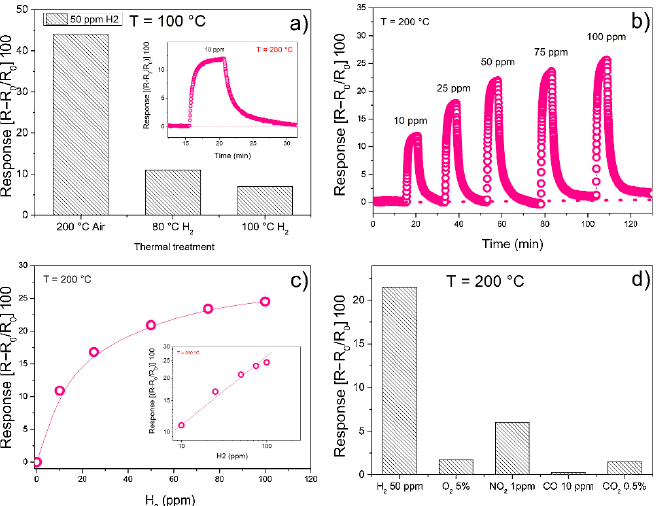
Figure 8. ( a ) Sensing response towards 50 ppm H 2 for sensors working at 100 ◦ C, but treated at the three different mentioned conditions; ( b ) Sensing response to pulses of hydrogen at concentration going from 10 ppm to 100 ppm, for the sensing film first annealed at 200 ◦ C and working at 200 ◦ C; ( c ) Calibration curve; ( d ) Sensing response to different gases at the indicated